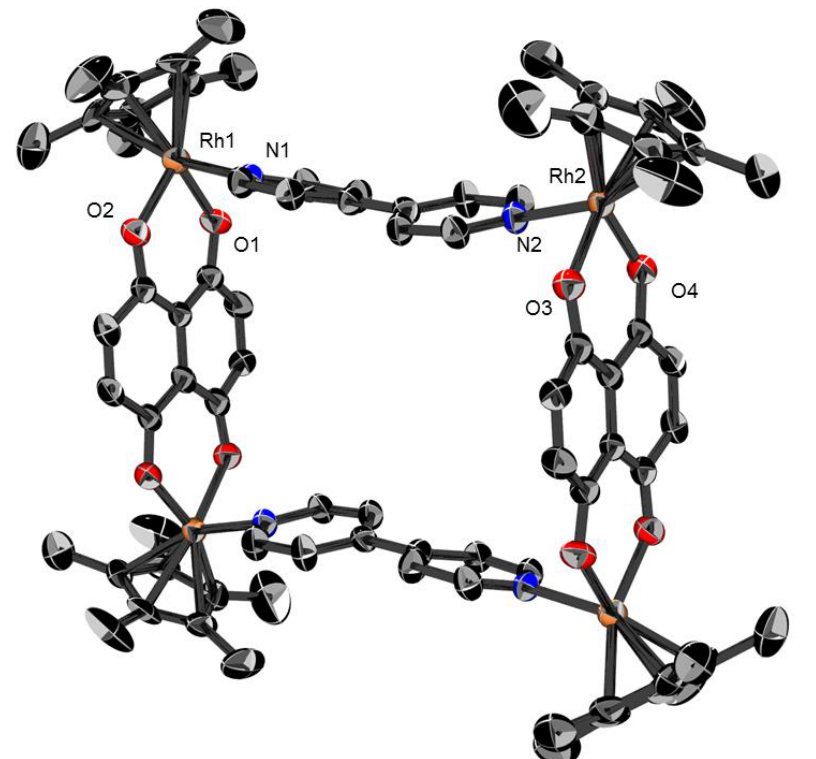
Figure 4. Molecular structure of metalla-rectangle 5 at 50% probability level ellipsoids with hydrogen atoms, dichloromethane molecules and triflate anions omitted for clarity.